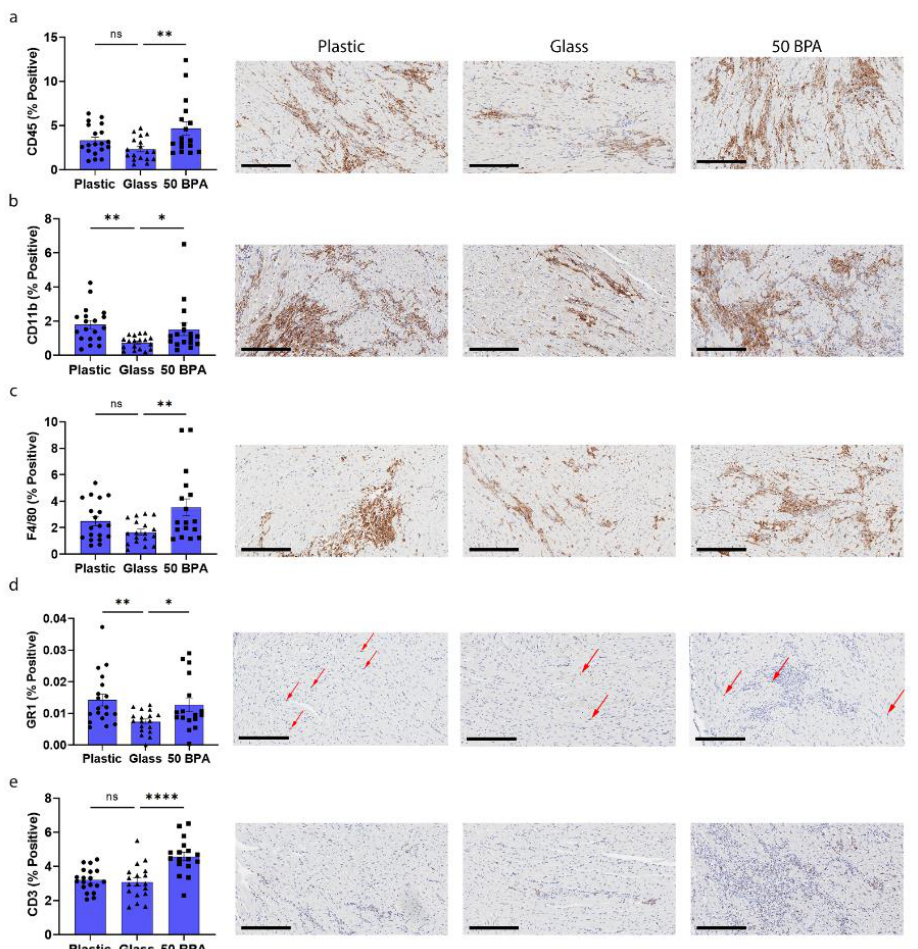
Figure 5. Plastic caging increases macrophages and neutrophils during acute myocarditis in BALB/c males. Male BALB/c mice were given normal drinking water (drinking water that did not contain BPA) for 2 weeks and housed either in glass cages/water bottles (glass) or plastic cages/water bottles (plastic) with soy-free food and bedding. BALB/c mice were housed in glass cages/water bottles with soy-free food and bedding and administered either normal drinking water (drinking water that did not contain BPA) (glass) or 250 μ g BPA/L water (50 BPA) for 2 weeks. Mice were injected i.p. with 10 3 PFU of CVB3 on day 0 and harvested at day 10 pi. Five micron sections were stained with antibodies against ( a ) CD45 (total lymphocytes), ( b ) CD11b+ cells (i.e., macrophages, neutrophils, mast cells), ( c ) F4/80+ macrophages, ( d ) GR1 (neutrophils), ( e ) CD3+ T cells, and positive pixels were compared to total positive and negative pixels to determine % positive. Data shown as scatter plot and mean +/ − SEM using one-way ANOVA with Holm–Š í d á k’s multiple comparisons test for 17–19 mice/group (* p < 0.05), (** p < 0.01), (**** p < 0.0001). Representative images of positive-stained cells (brown) in plastic caging (plastic), glass caging (glass) and 50 BPA in drinking water (50 BPA) in glass cages shown for ( a ) CD45, ( b ) CD11b, ( c ) F4/80, ( d ) GR1, and ( e ) CD3. Red arrow points to brown GR1-positive cells (magnification 200 × , scale bar 200 µ